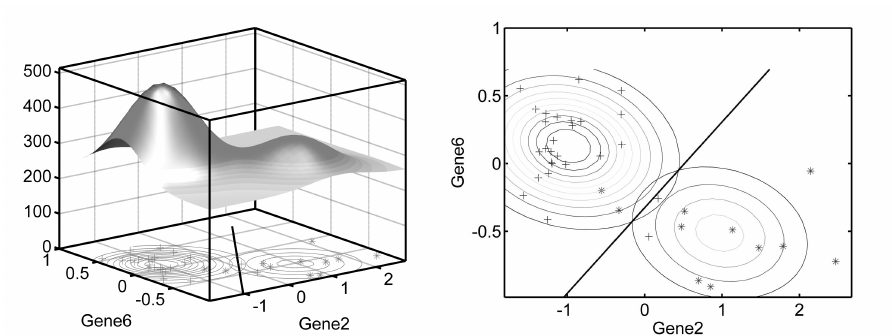
Figure 2. Estimated classifier functions and boundary of linear discrimination LDF; apparent error = 0.105, CV = 0.105 (SD = 0.07) symbols “+”. Apparent (resubstitution) errors and CV errors with corre- sponding standard deviations (SD) are given in the titles of the